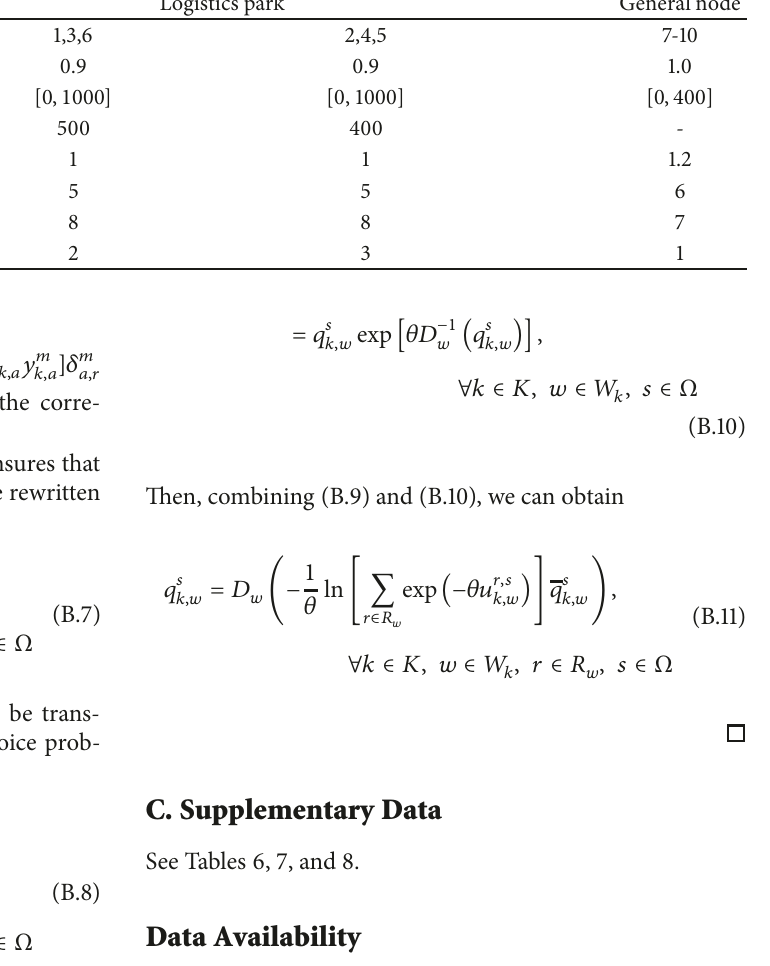
Table 7: Basic data of each logistics node in the network. Logistics